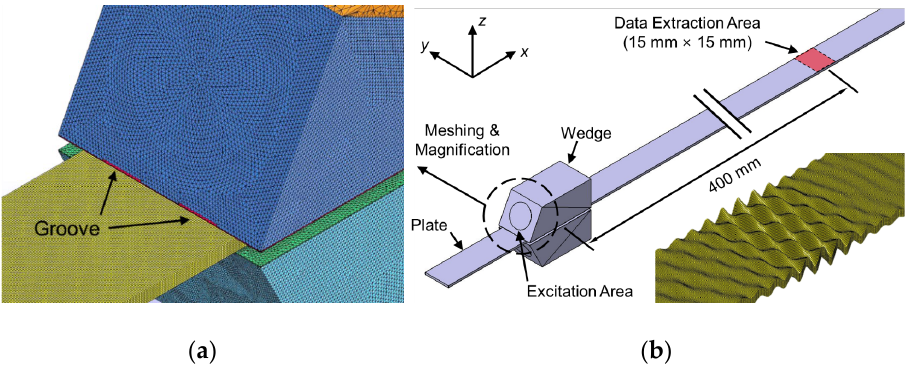
Figure 9. ( a ) Meshed FEM model and ( b ) overview of the entire FEM model and propagation snapshot of the excited A(0,4) mode.